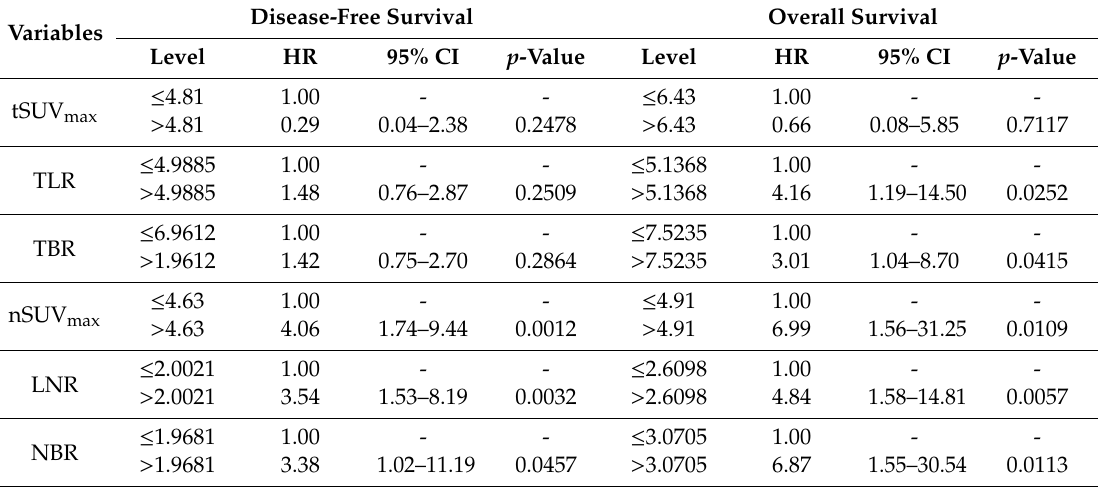
Table 3. Multivariate analyses of PET parameters in relation to DFS and OS after adjusting for clinicopathologic factors.